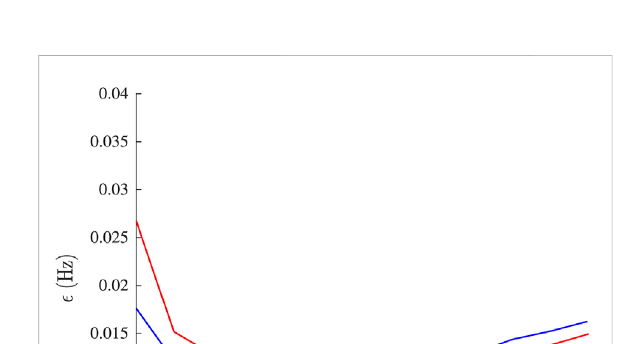
FIGURE 4 Box-plot of ϵ BP (red) and ϵ OSP (blue) from simulation as a function of signal quality S . ( p ) denotes signi fi cant differences ( p < 0.05).